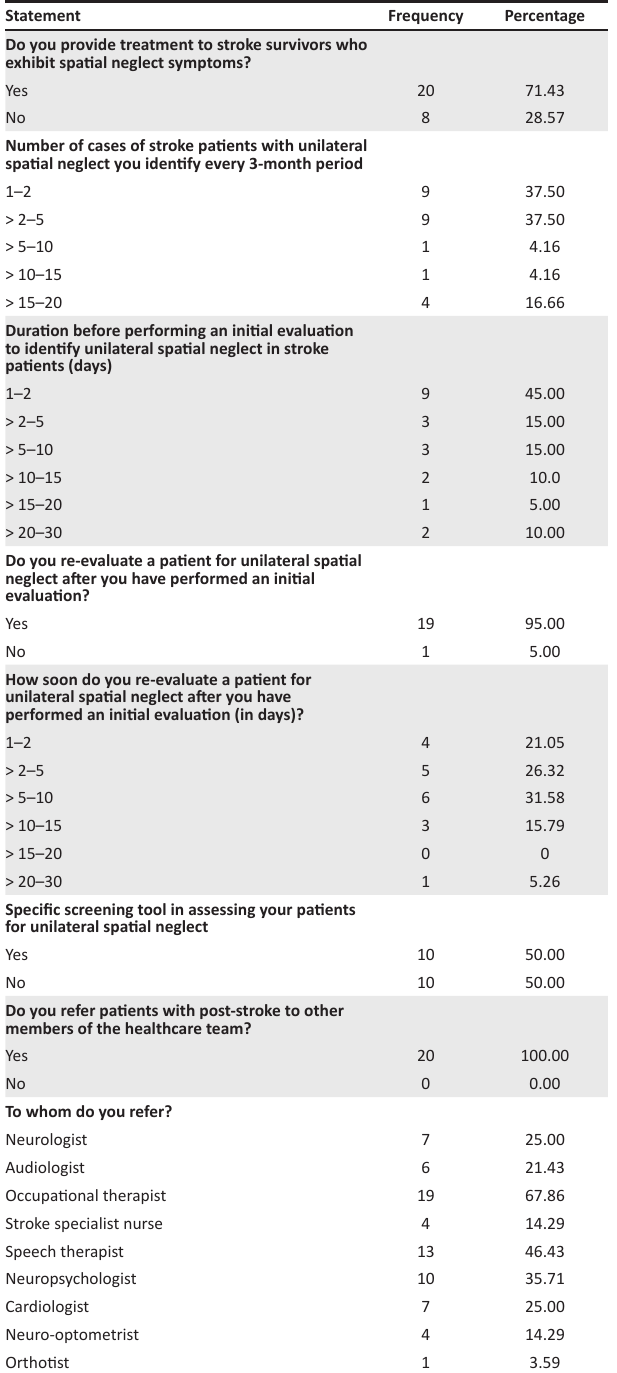
TABLE 5: Physiotherapists’ practice in post-stroke unilateral spatial neglect management. Statement